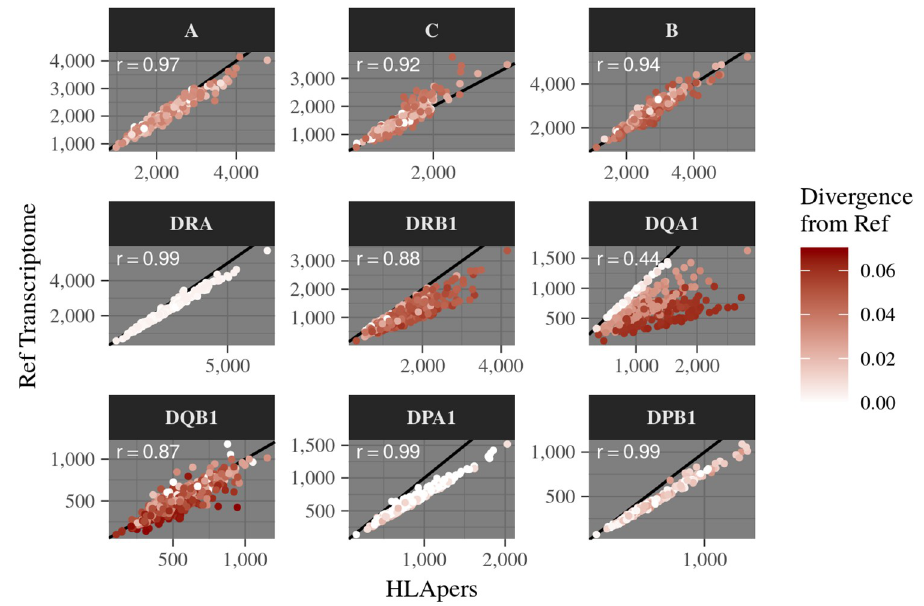
Fig 4. Expression estimates using personalized HLA genotypes (x-axis) versus the reference transcriptome (y-axis) in the index. For each individual we identify the average divergence (proportion of mismatches) with respect to the reference genome, indicated by the red gradient. For all loci with low correlations between expression quantification methods, there is a marked drop in expression estimates using the reference transcriptome when the alleles are most divergent from the reference. Expression estimates are in Transcripts per Million (TPM). r: Pearson correlation coefficient.